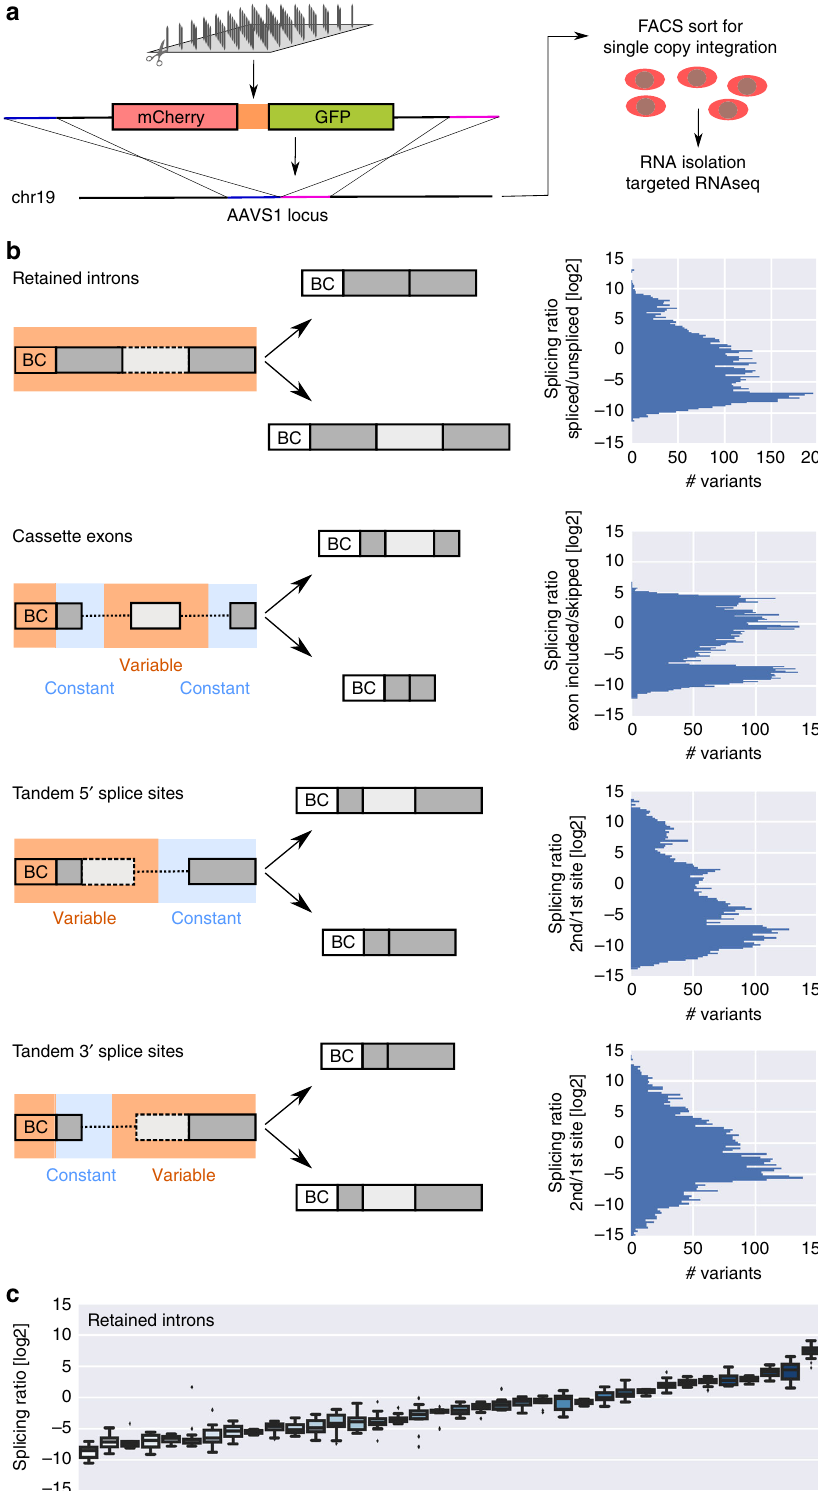
Fig. 1 High-throughput testing of rationally designed splice site variants. a Outline of the experimental pipeline. Designed synthetic oligonucleotide libraries were cloned in a splicing reporter and integrated in the AAVS1 locus of K562 cells, with a single library variant per cell. After FACS sorting, RNA was isolated and the reporter RNA was sequenced, leading to determination of splicing ratios for each variant. b Structure of the variable (orange) and constant (light blue) regions in the four splicing type libraries, with the two splicing outcomes and the corresponding histograms. Splicing ratios close to the upper or lower limit represent predominance of the upper or lower isoform in the schematic, respectively (BC: barcode). c Barcode controls for retained intron splicing ratios, box plots for groups of multiple barcodes for the same sequence variant ( n > 7 for all groups), plotted according to their mean splicing ratio (spliced/unspliced [log2]); boxes show the quartiles of the dataset, whiskers show the range of the distribution not including outliers (displayed as